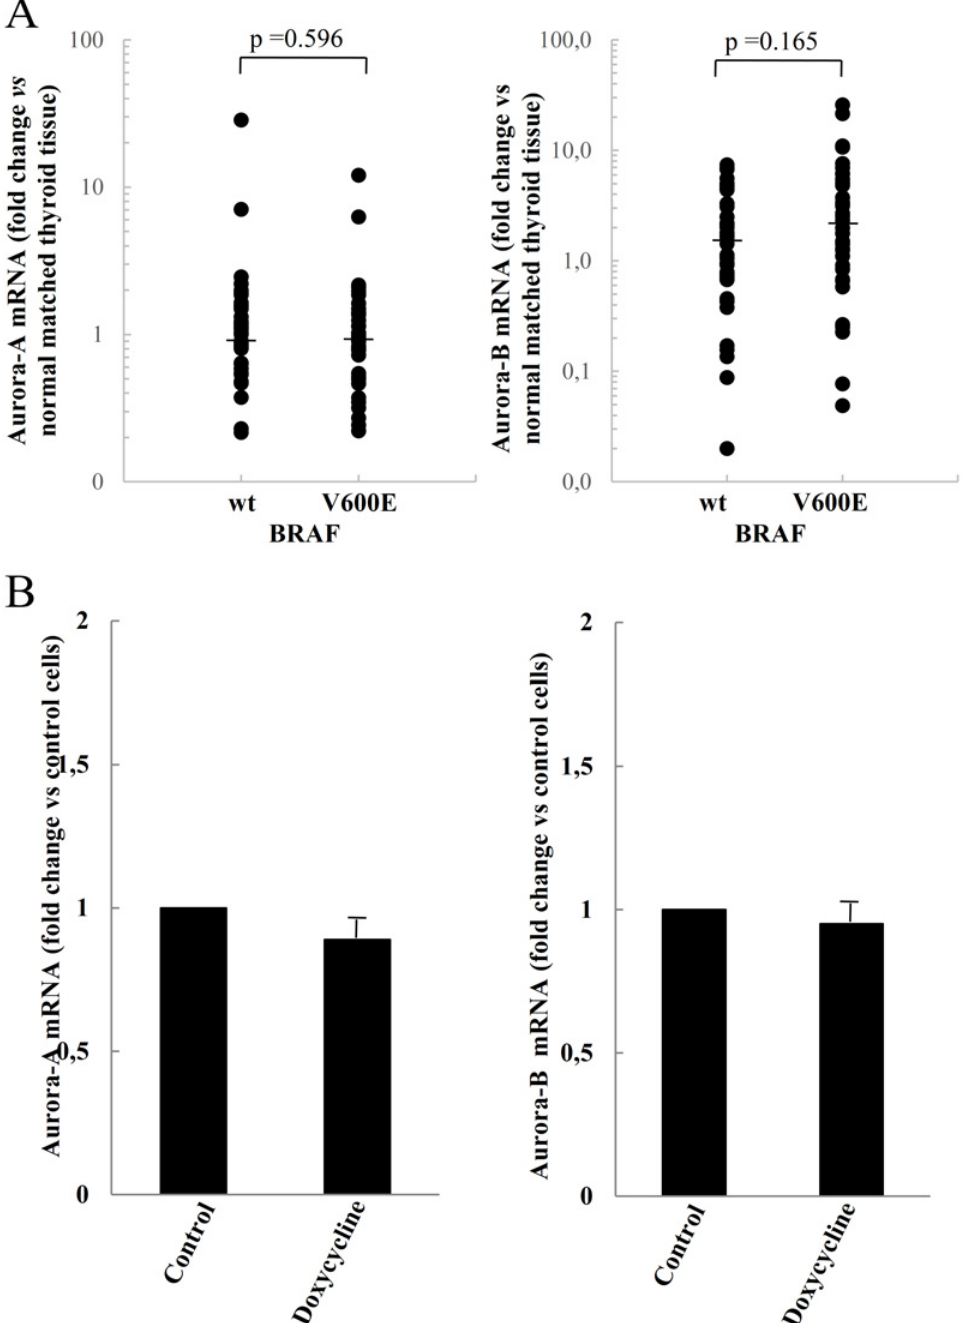
Fig 2. Lack of effects of BRAF V600E on the expression of Aurora kinases. A) Expression of Aurora-A and Aurora-B in papillary thyroid cancer tissues with wild type (n = 38) or mutated BRAF (n = 37). The fold changes were calculated considering the Aurora-A or Aurora-B mRNAs level observed in normal matched thyroid tissue equal to 1. The statistical evaluation of the data was performed by applying the non-parametric Mann Withney test. The small bars in the graph indicate the median values. B) Effect of BRAF V600E on Aurora kinases mRNAs in PCCL3 cells. The latter were induced to express BRAF V600E in a doxycycline-dependent manner. The fold changes of Aurora kinase mRNA were normalized against the non-treated cells.